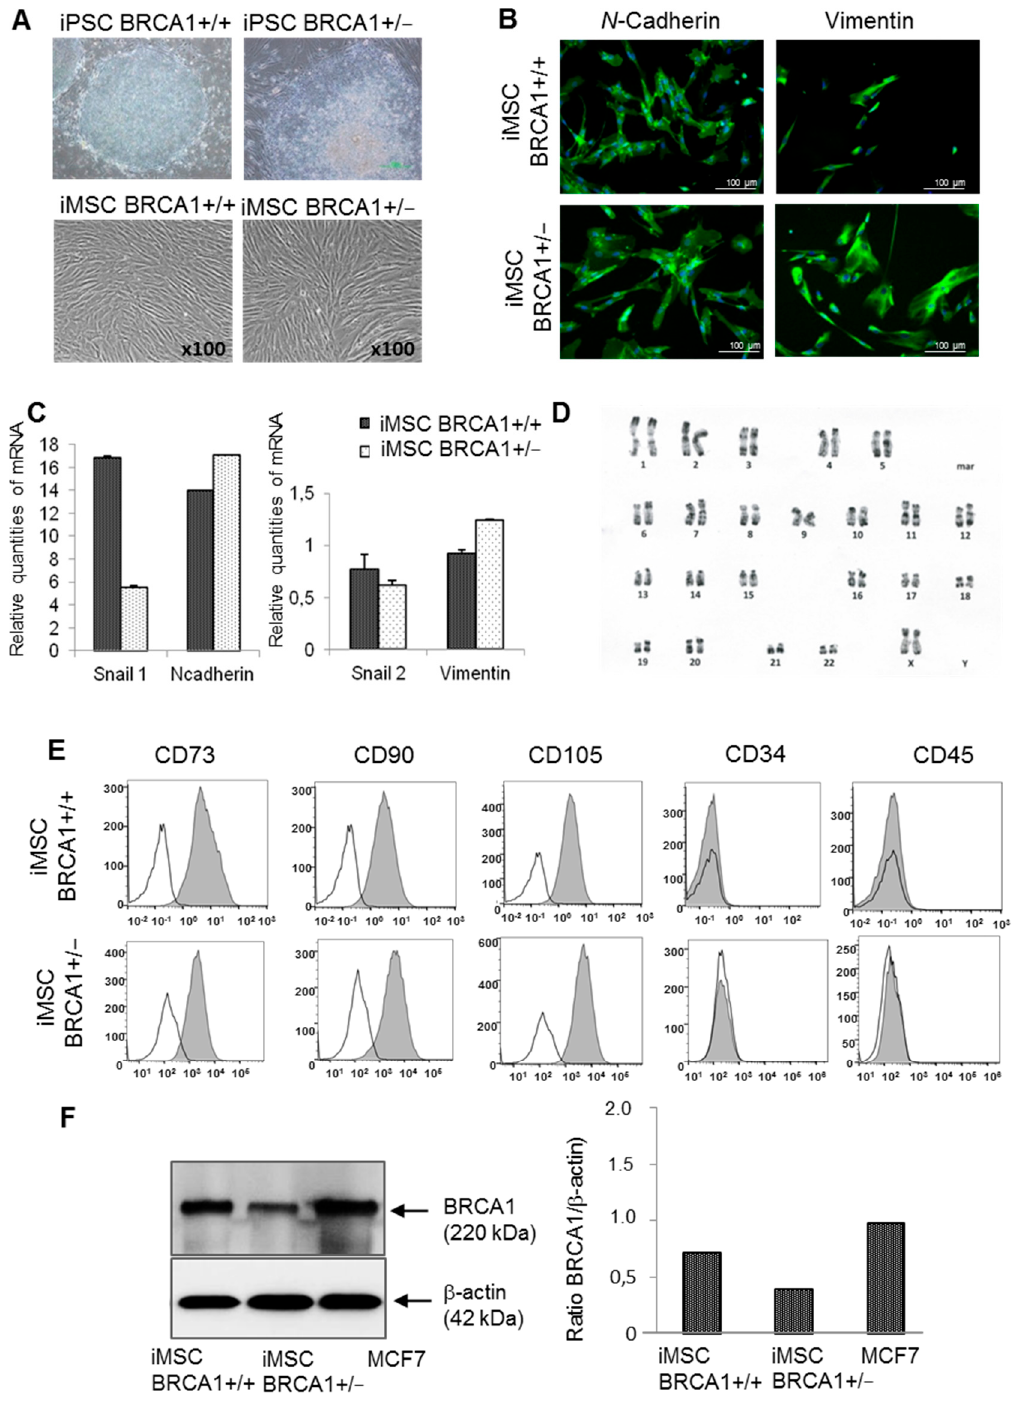
Figure 1. Characteristics of induced pluripotent stem cell (iPSC)-derived BRCA1 +/ − induced mesenchymal stem cells (iMSCs) and BRCA1 +/+ iMSCs. ( A ) Morphology of iPSCs and iPSC-derived iMSCs, characterized by spindle-shaped cells. ( B ) Immunofluorescence images of iPSC-derived iMSCs stained with N -Cadherin and Vimentin mesenchymal markers. ( C ) Expression of mesenchymal markers (Snail 2, N -Cadherin, Vimentin, and Snail 1) in both cell lines as determined by RT-qPCR. ( D ) BRCA1 -deleted iMSCs exhibit a normal karyotype. ( E ) Expression of characteristic MSC markers by flow cytometry. White histograms indicate negative expression. ( F ) Western blot of BRCA1 protein levels in deleted BRCA1 +/ − and wild-type BRCA1 +/+ iMSCs. Immunoblotting revealed a decrease in BRCA1 protein level in the BRCA1 -mutated MSCs.